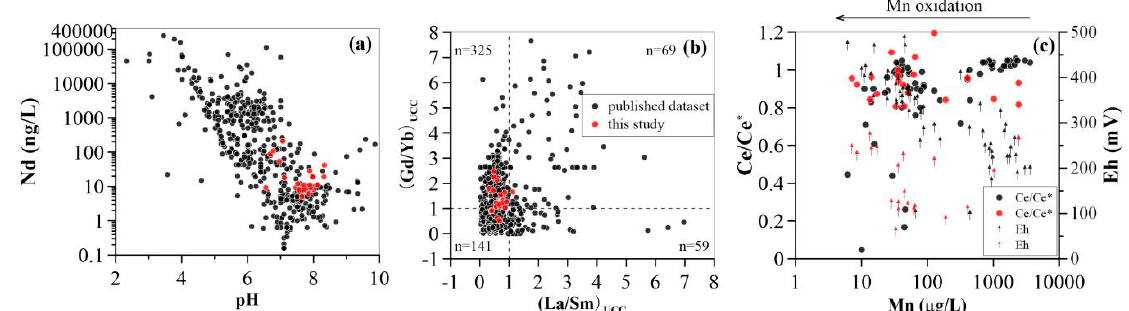
Figure 5. Comparisons of the data set in present study with those from the literature reviewed by Noack et al. [27]. ( a ): Nd concentrations vs pH; ( b ): (La/Sm) UCC vs (Gd/Yb) UCC ; ( c ): Mn concentrations vs. Ce anomaly and Eh. Data sources displayed in panel c are from [2,3,5] (black points and arrows) and the present study (red points and arrows).